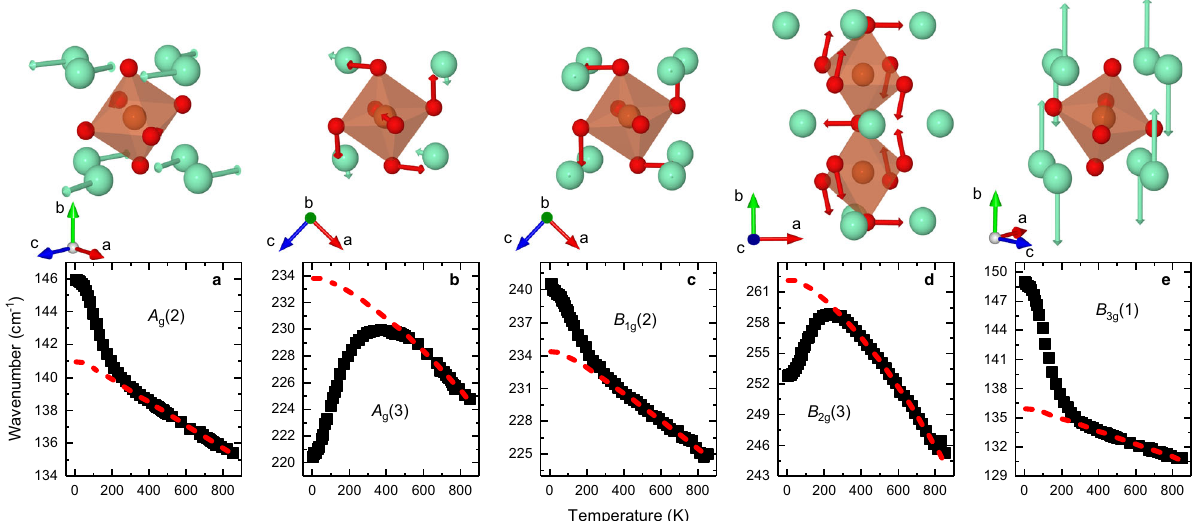
Fig. 3 Anomalous deviation of lattice vibrations. Temperature dependent frequencies of fi ve different vibrations that show an anomalous evolution resulting from the induced Sm 3 + spin ordering. The displacement patterns 56 involve pure samarium displacements a , e , in-phase b , c and out-of-phase d rotations of the octahedra. The dashed red lines indicate the evolution expected from an undisturbed anharmonic frequency evolution. The Raman spectra that provide the basis for these data were measured in the following light polarization settings: A g : x(zz)x ̅ , B 1g : z(xy)z ̅ , B 2g : y(xz)y ̅ , B 3g : x(yz)x ̅